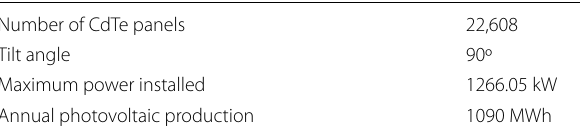
Table 2 Data for cadmium telluride photovoltaic system sizing